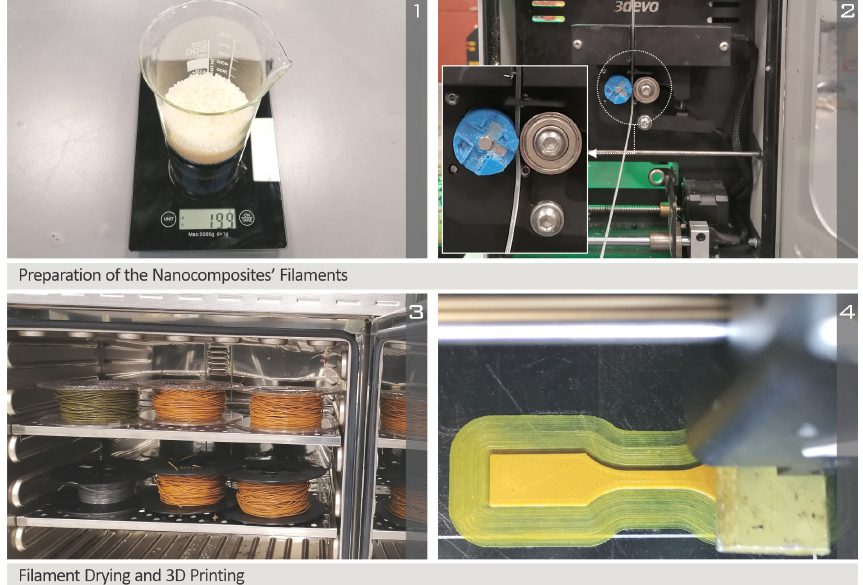
Figure 1. Process for the synthesis of the nanocomposites: ( 1 ) raw material preparation, ( 2 ) filament extrusion (3D Evo Composer), ( 3 ) filament drying, and ( 4 ) 3D printing of specimens (Intamsys Funmat HT).